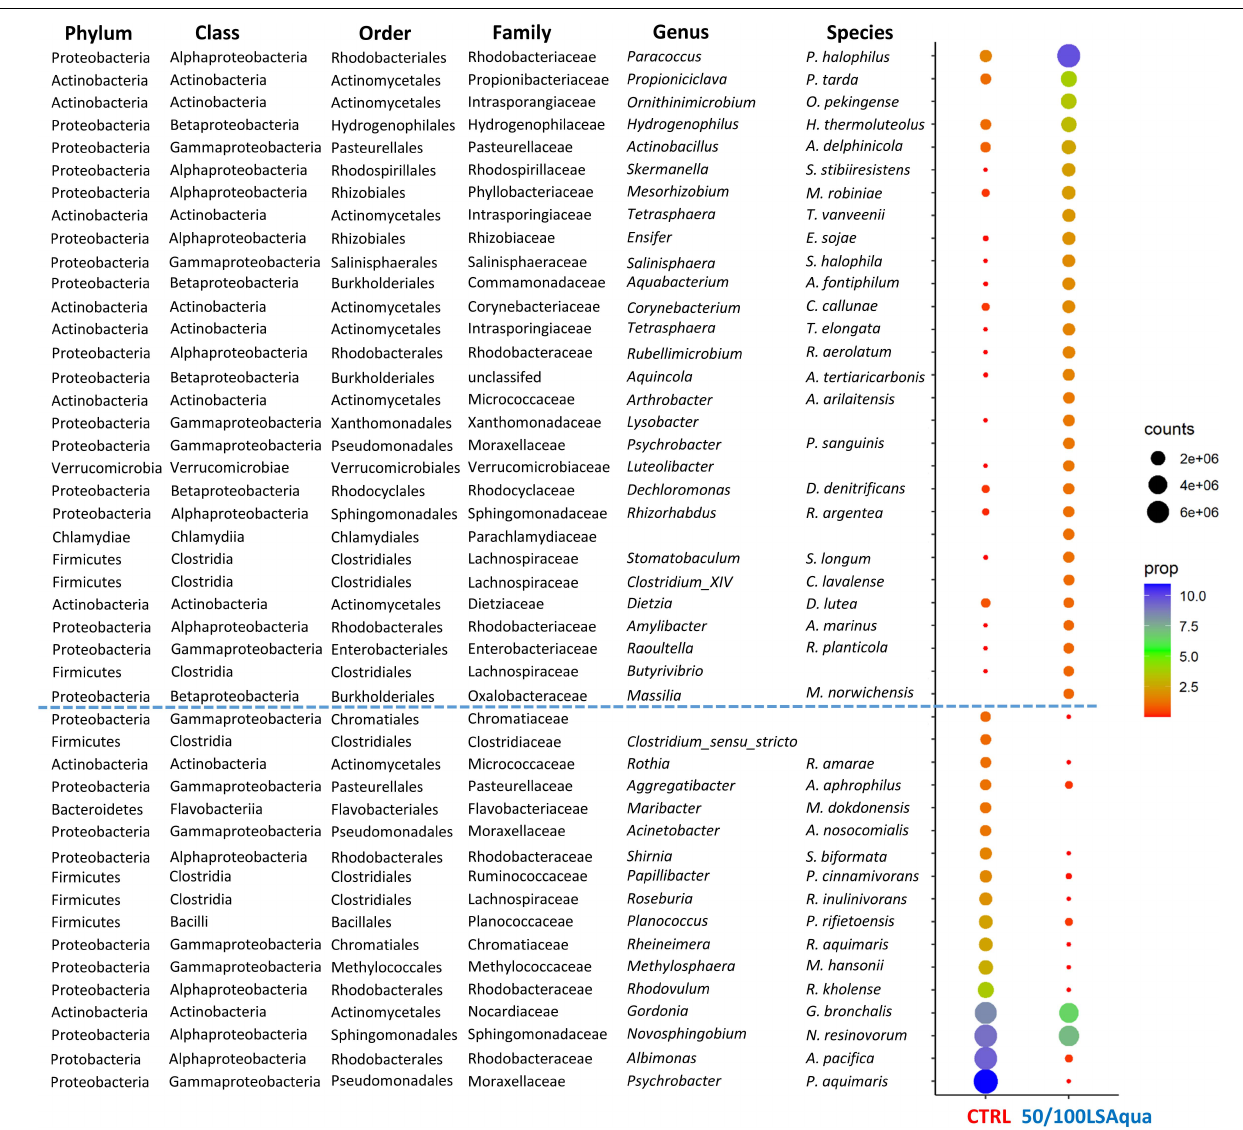
FIGURE 6 | Dotplot map depicting the OTUs with more than 1% of proportion in at least one dietary group. The size of the dots represents the normalized counts in each group. The color scale represents the mean abundance, in percentage, of each OTU within each group. CTRL and 50/100LSAqua refers to control and combined LSAqua-based diets, respectively. OTUs above the dotted blue line showed an higher abundance in 50/100LSAqua group; OTUs below the blue dotted line showed an higher abundance in CTRL